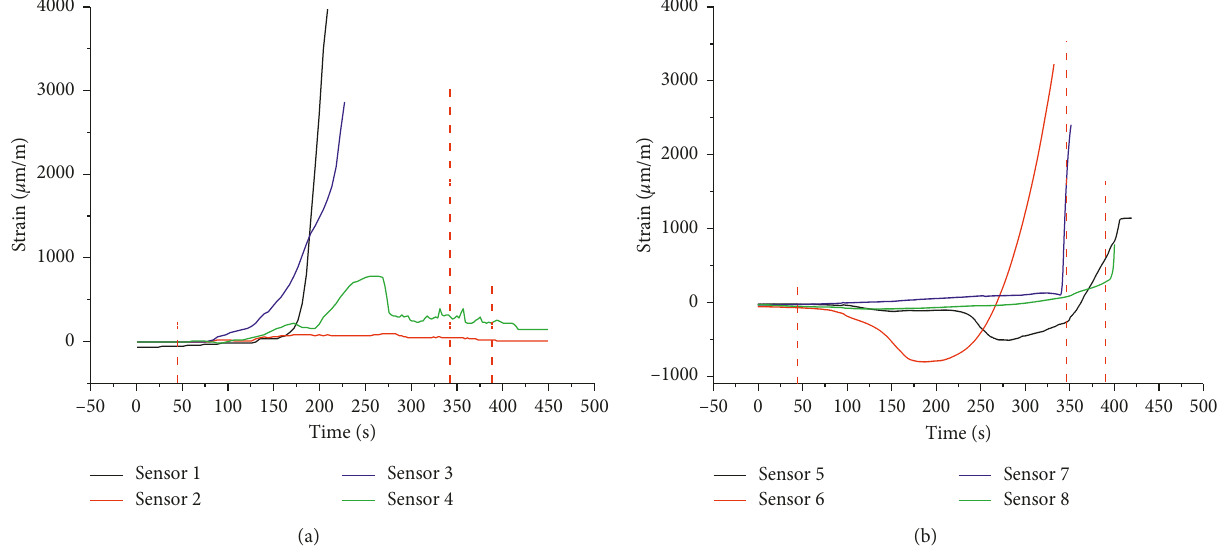
Figure 12: Strain time phases of 40mm from the wall of roadway: (a) the division of strain stage of points 1–4 and (b) the division of strain stage of points